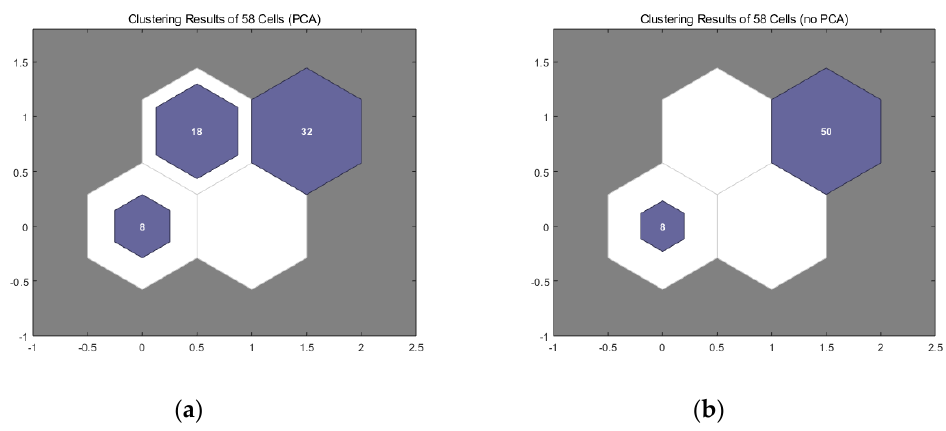
Figure 6. SOM clustering results (four neurons), ( a ) Group 1, ( b ) Group 2.